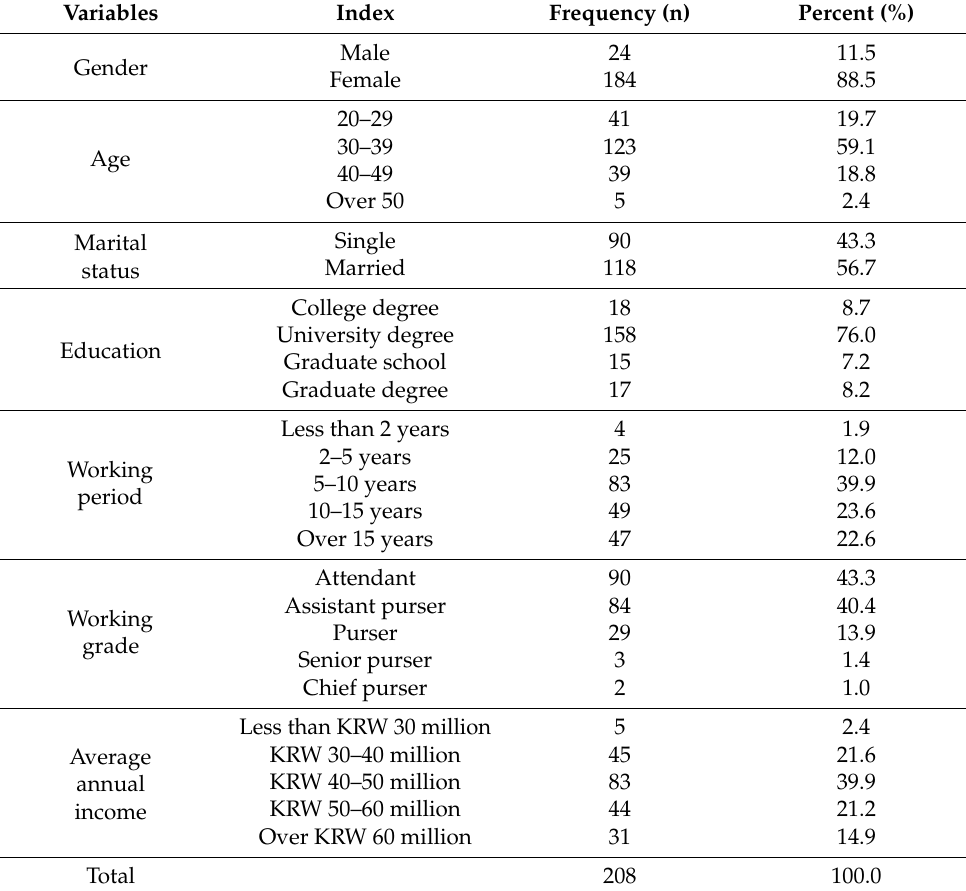
Table 1. Characteristics of the Sample (N =